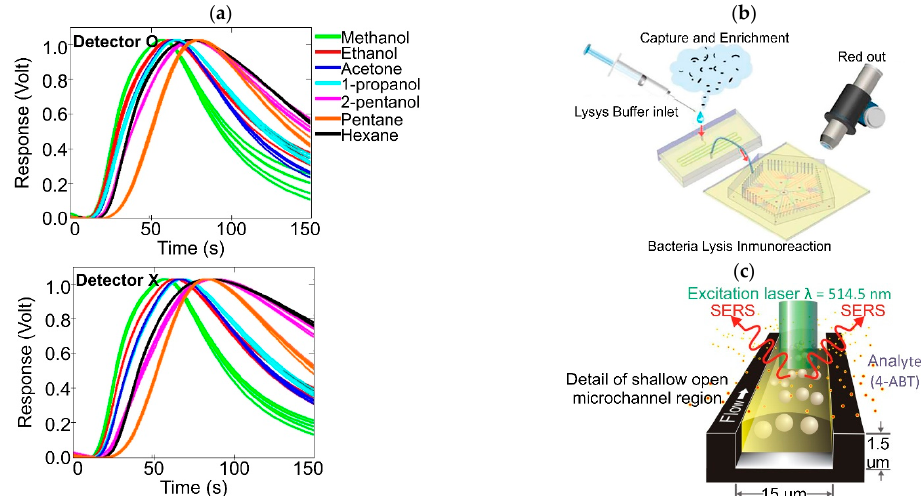
Figure 8. Continuous flow microfluidic techniques for the detection of PM in the air. ( a ) Responses of the O detector and the X detector to different gaseous analytes. Modified from Reference [185]. Copyright (2017) with permission from Elsevier. ( b ) Schematic diagram of a LAMP-based micro- fluidic device for airborne bacterial identification. Reprinted with permission from Reference [190]. Copyright (2014) American chemical Society. ( c ) Schematic diagram microfluidic/SERS ana- lytical device. Modified from Reference [199]. Copyright (2007) National Academy of Sciences of